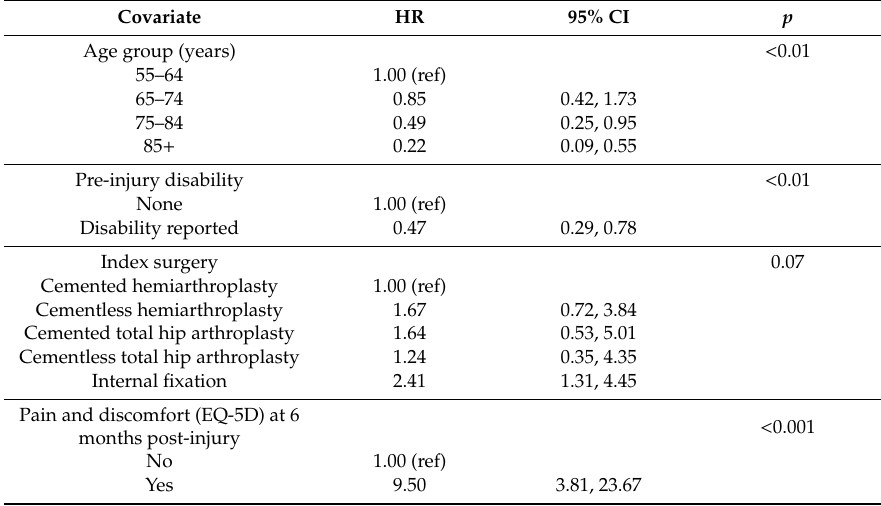
Table 3. Factors associated with future revision arthroplasty / conversion to arthroplasty, adjusted for confounding (only participants with no covariates missing, n =